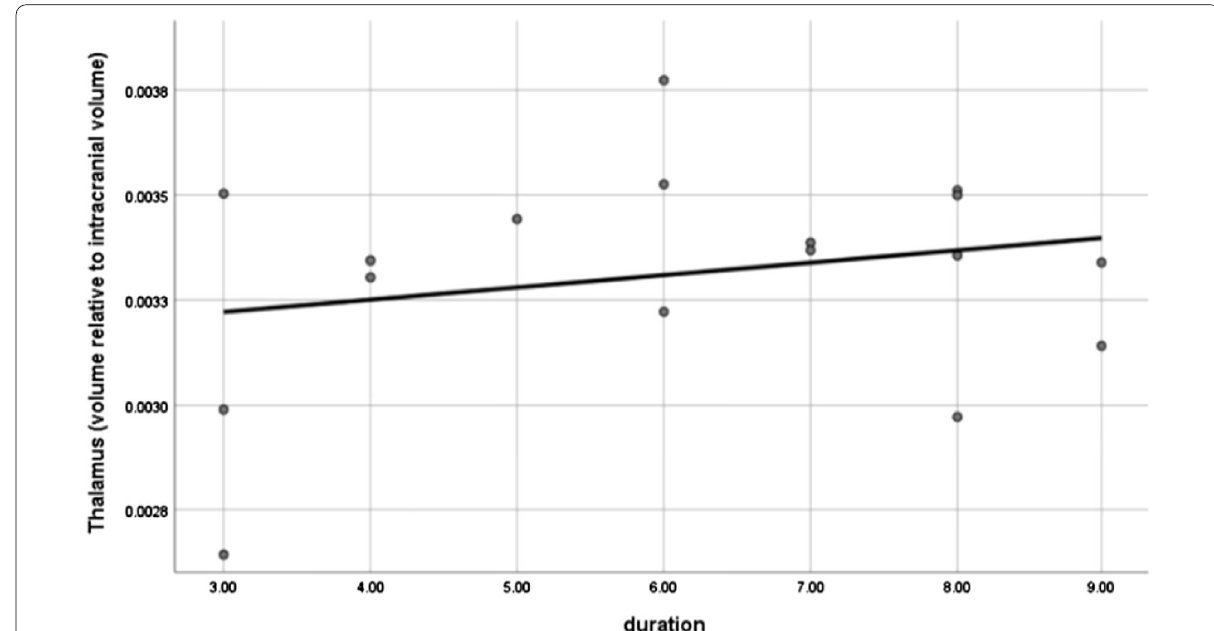
Fig. 20 Relation between loss of thalamic volume and duration of illness in patients with thalamic